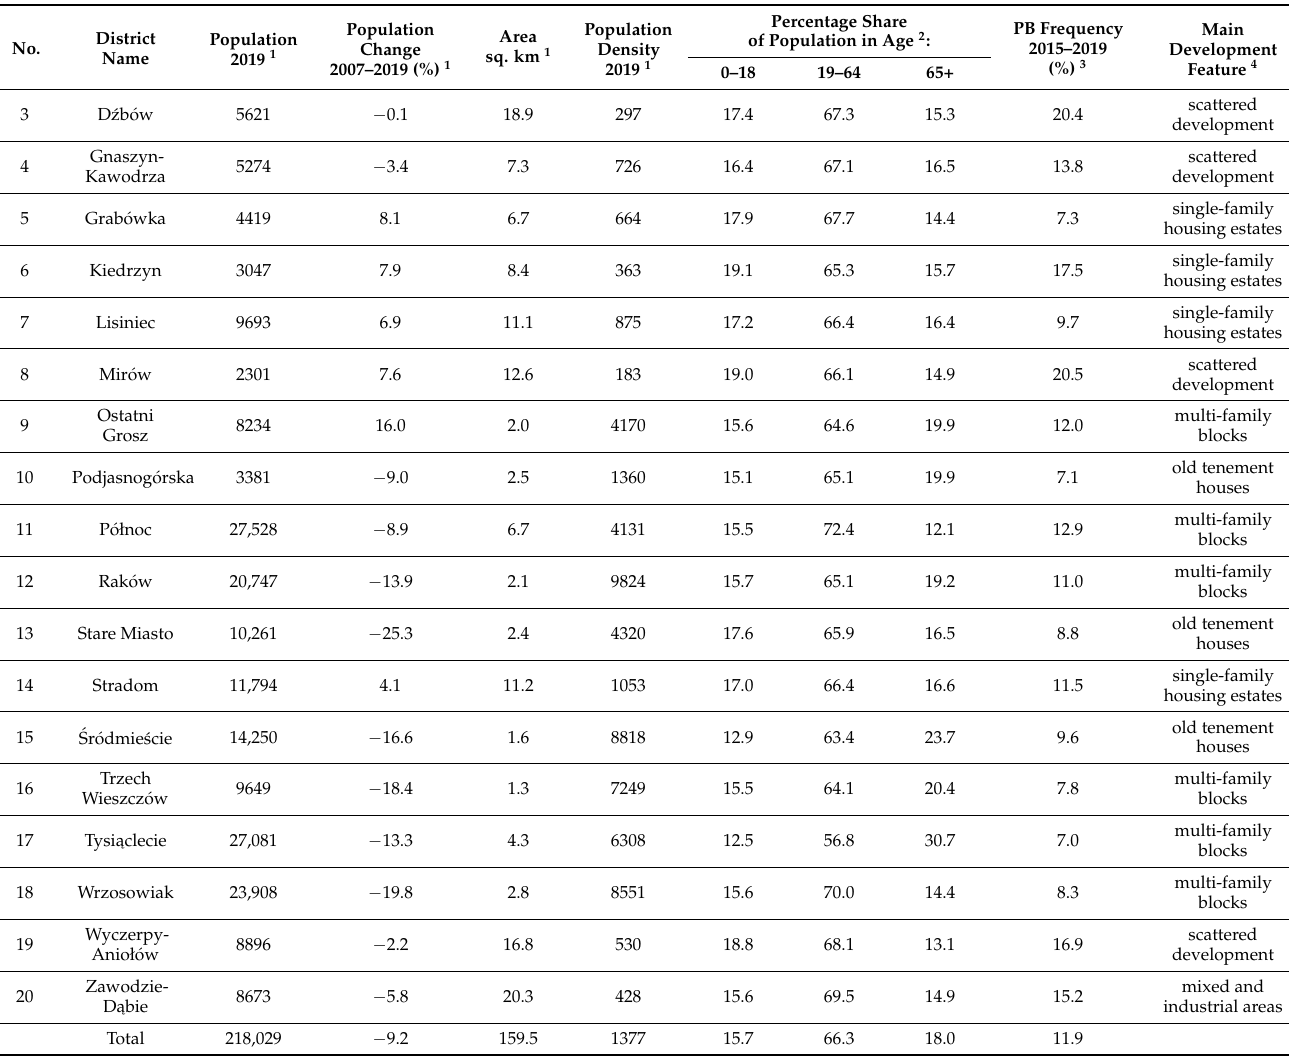
1 Our own calculation based on data from Cz˛estochowa City Hall. Population density—population per square kilometer; 2 based on [86]; 3 the statistical mean of the PB frequency (the number of voters in relation to the district population, in percentage); and 4 the typology of the city districts based on